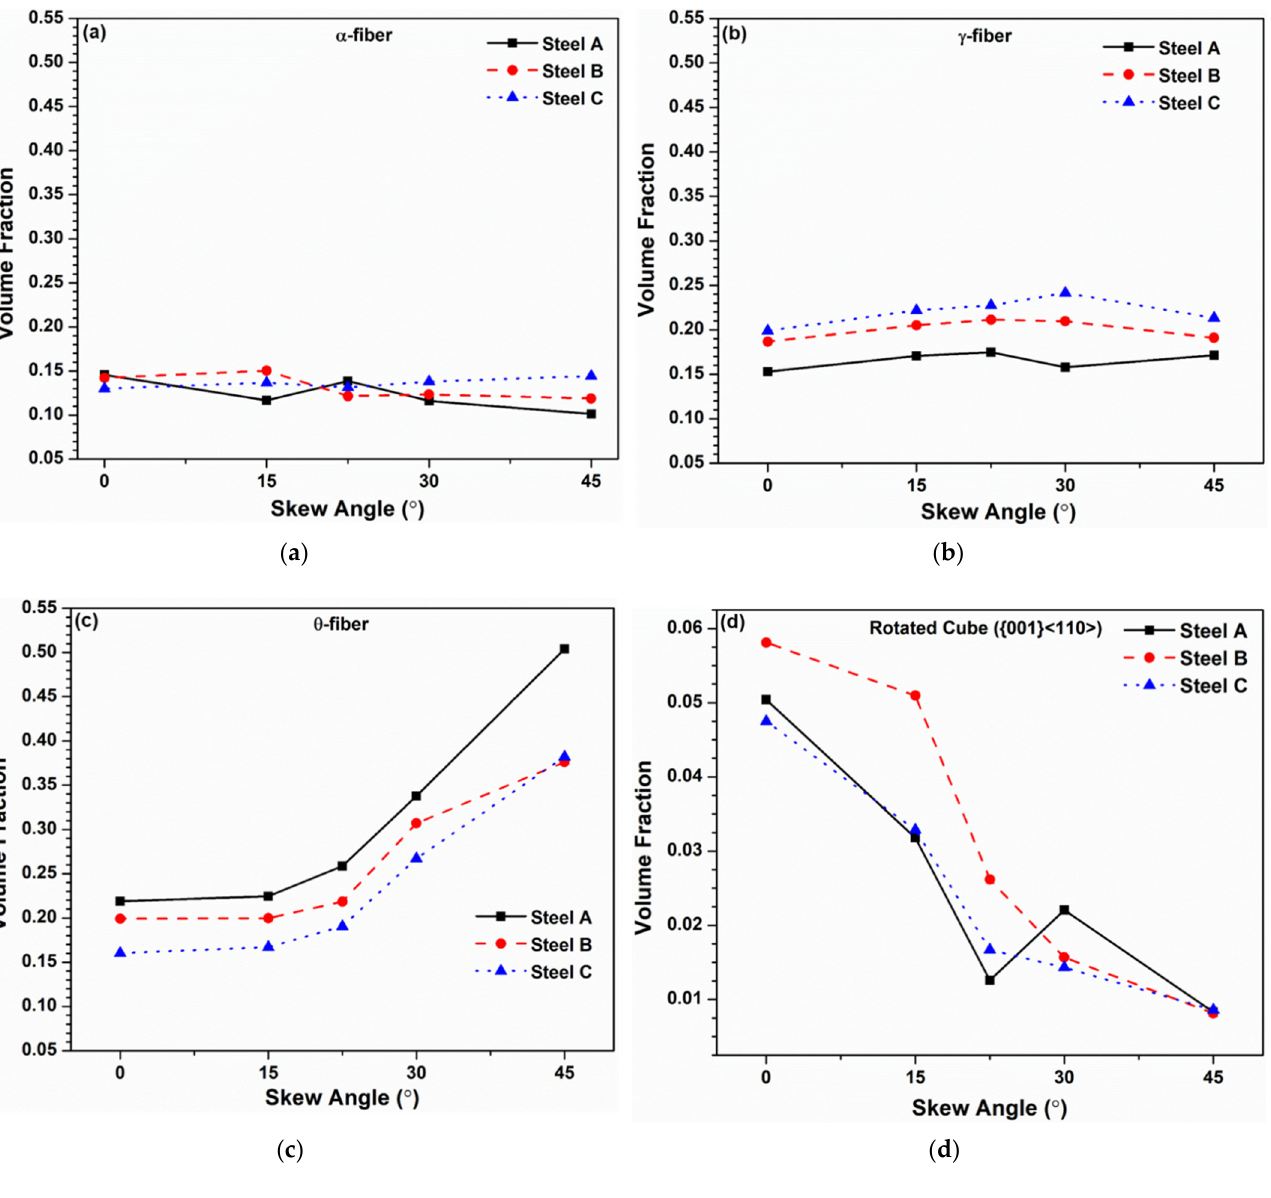
Figure 7. Comparison of the volume fractions of common texture fibers, ( a ) α -fiber, ( b ) γ -fiber, ( c ) θ -fiber and the rotated cube component ( d ), after skew cold rolling with bidirectional feeding.